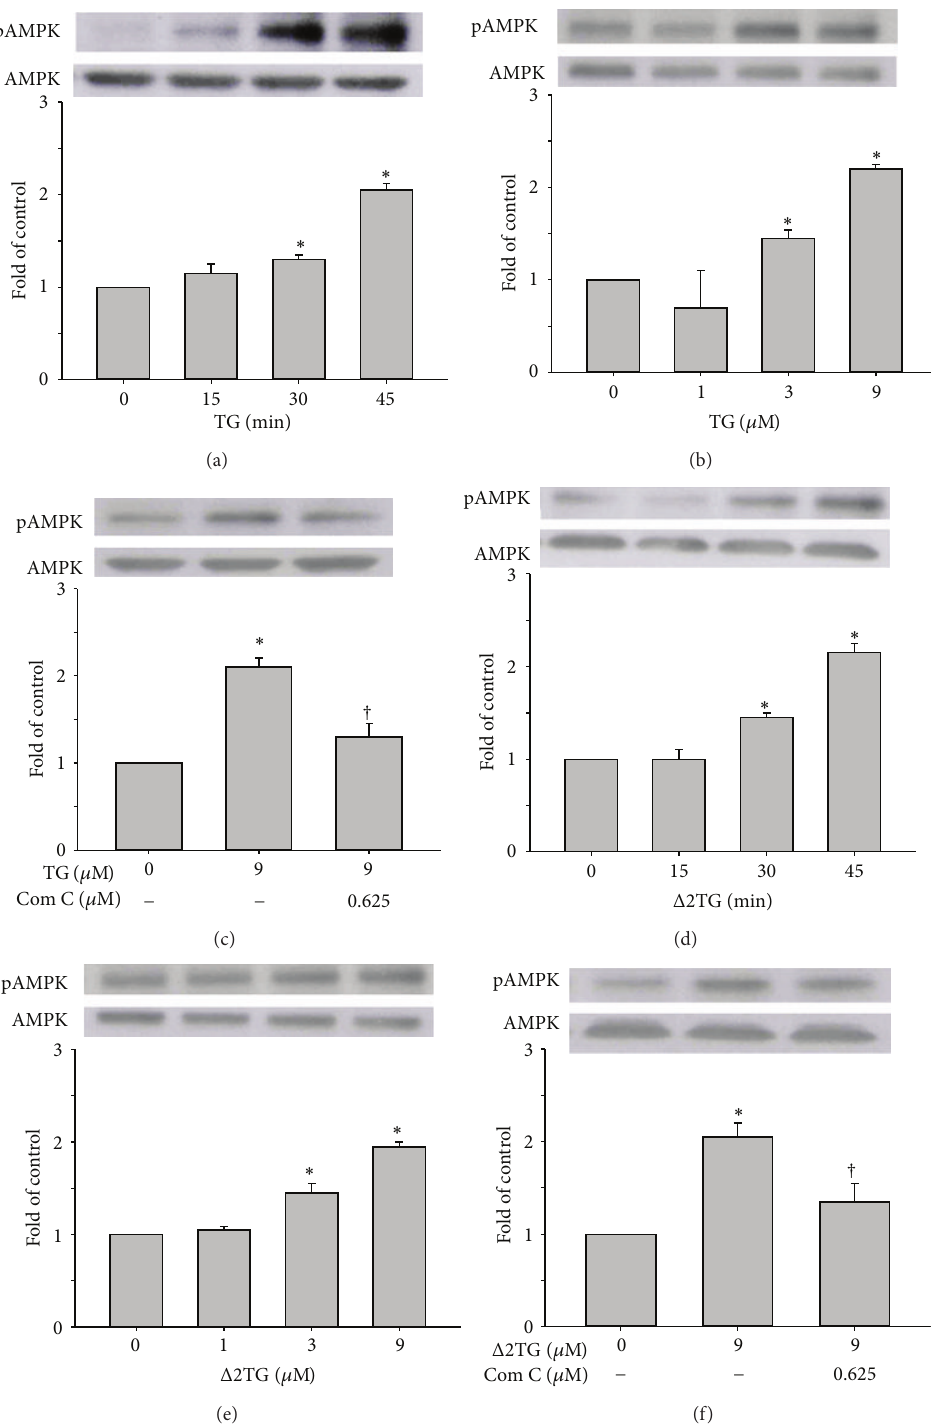
Figure 5: TG and Δ 2TG enhanced AMPK phosphorylation. Macrophages were treated with 9 𝜇 M of TG or Δ 2TG for the indicated time ((a), (d)) or with the indicated concentration of TG or Δ 2TG for 45 min ((b), (e)). ((c), (e)) Macrophages were incubated for 1h with compound C (an AMPK inhibitor) and then for 45 min with or without 9 𝜇 M TG or Δ 2TG in the continued presence of the inhibitor, and then, the phosphorylated AMPK expression was measured in cell lysates by Western blotting. AMPK was used as the loading control. ∗ 𝑃 < 0.05 as compared to the untreated cells. † 𝑃 < 0.05 as compared to the TG or Δ 2TG-treated